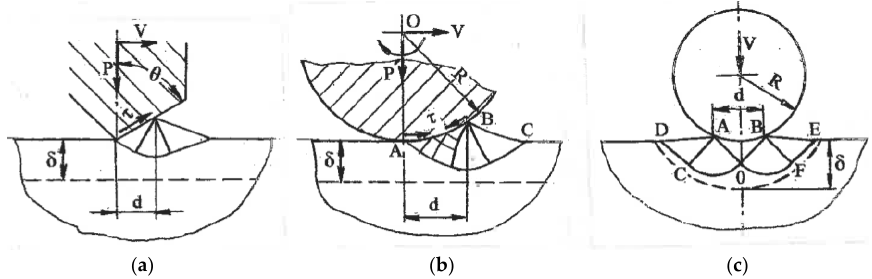
Figure 11. Slip line solutions for surface SPD: ( a ) contact sliding; ( b ) contact rolling; ( c ) contact penetration.